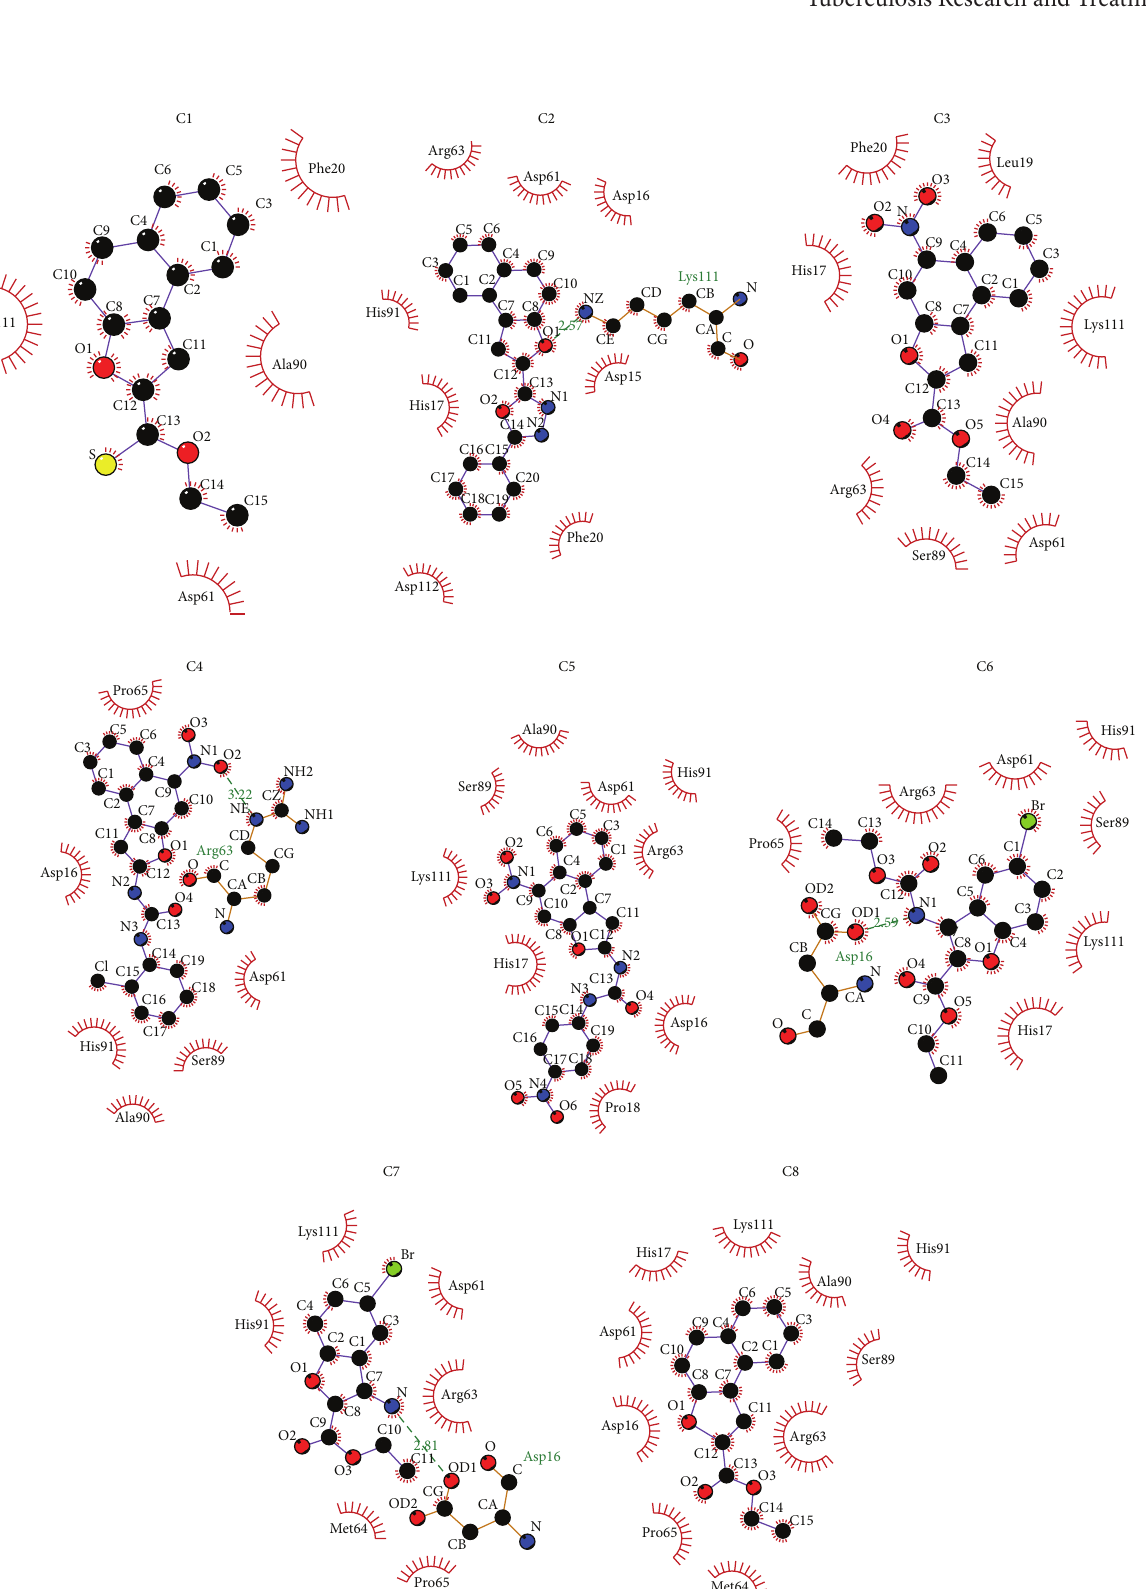
Figure 4: 2D representation using Ligplot + of all compounds interacting at the active site of NarL. Hydrogen bonds are represented by dashed